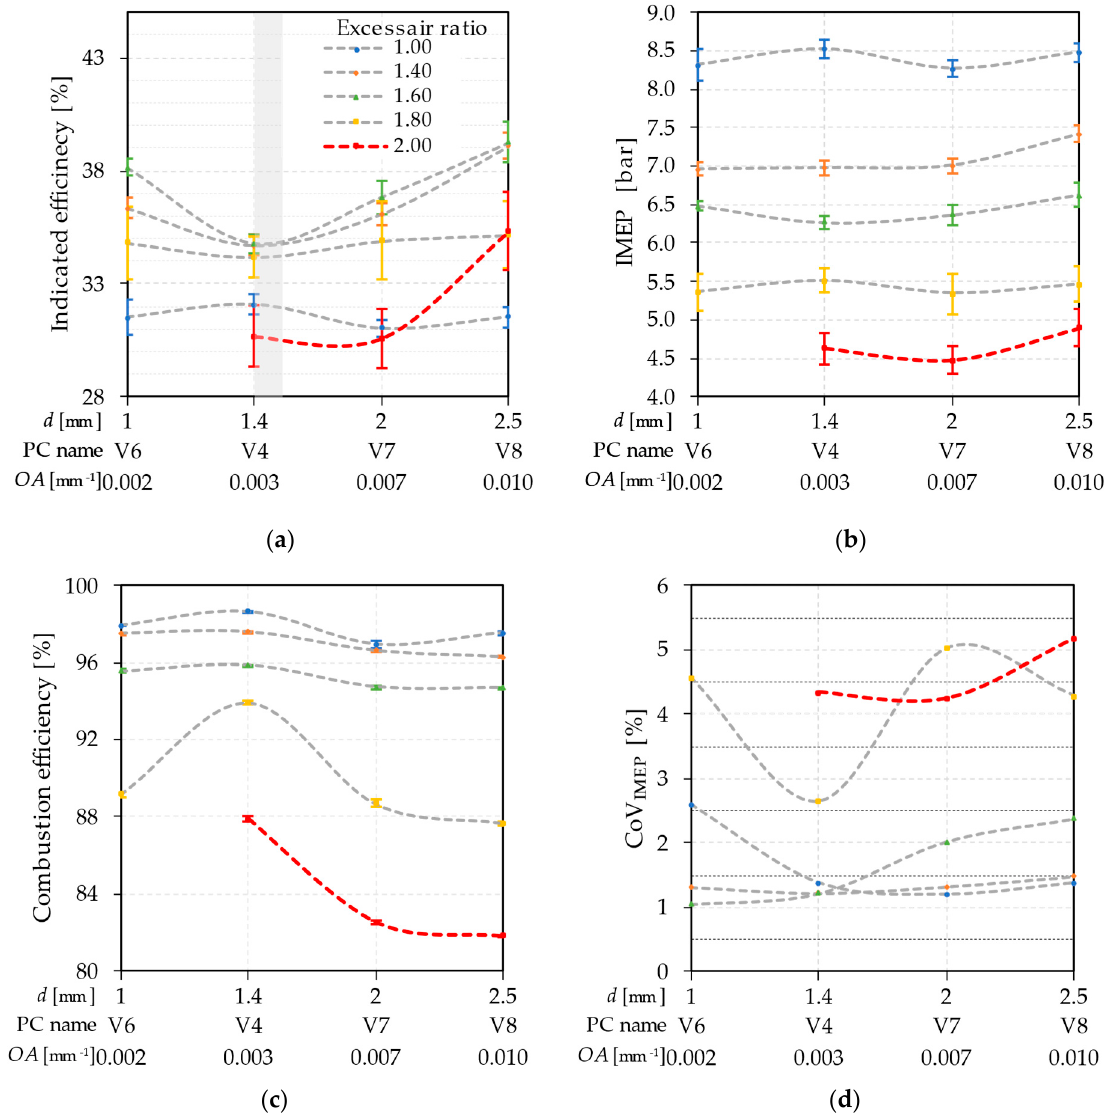
Figure 9. Influence of orifice diameters on performance engine performance: ( a ) indicated efficiency (shaded area is the OA area recommended by [9]); ( b ) IMEP; ( c ) combustion efficiency; and ( d ) combustion stability trough coefficient of variation of IMEP. All pre-chambers have an VR = 3.27% and 4 orifices.